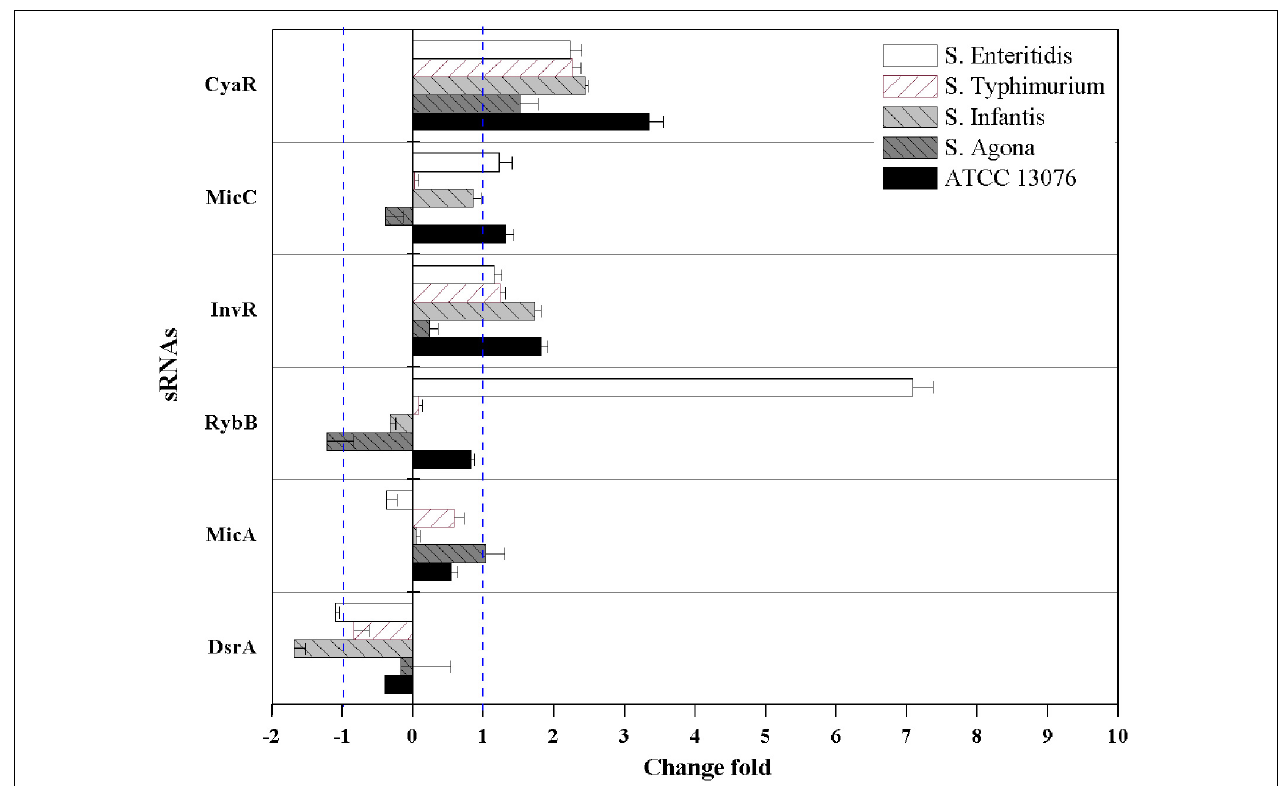
FIGURE 5 | The relative expression of sRNAs of five Salmonella strains when exposed to hyperosmotic stress. Each symbol indicates the mean ± standard deviation of five independent experiments ( n =